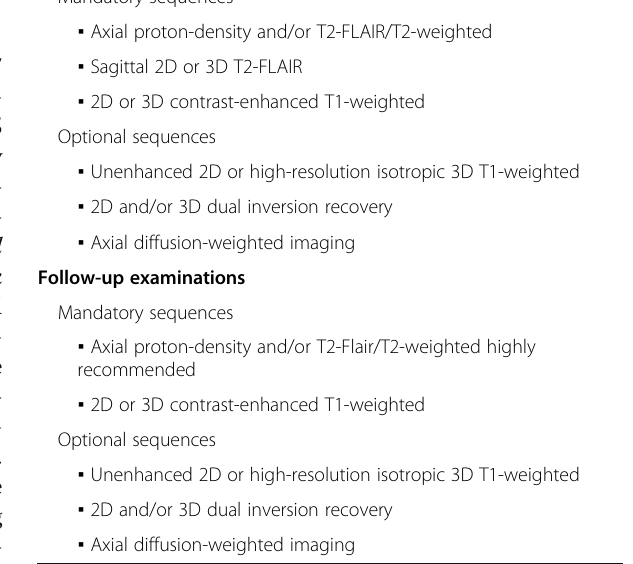
Abbreviation : FLAIR Fluid-attenuated inversion recovery, MS Multiple